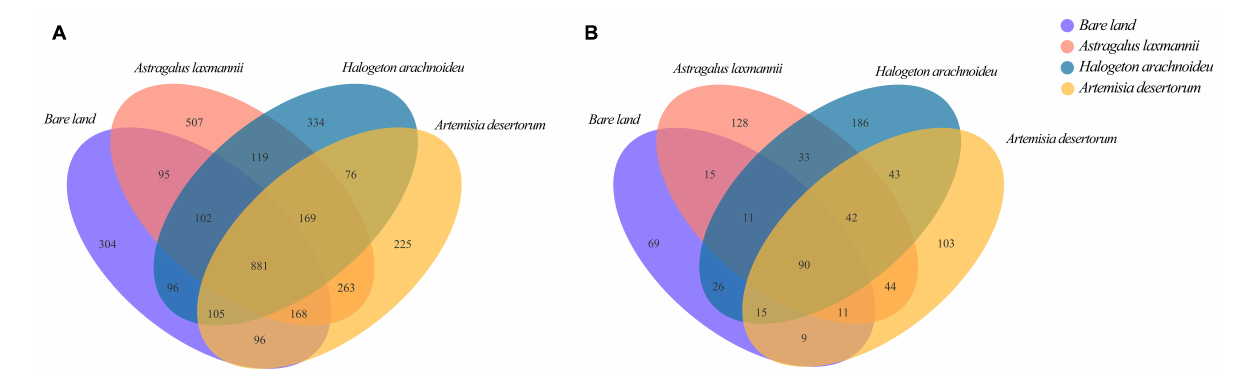
( Figure 2A ), while soil fungi had 69, 128, 186, and 103 unique OTUs ( Figure 2B ). Re-vegetated soils had more unique fungal OTUs than bare land soil ( Figure 2